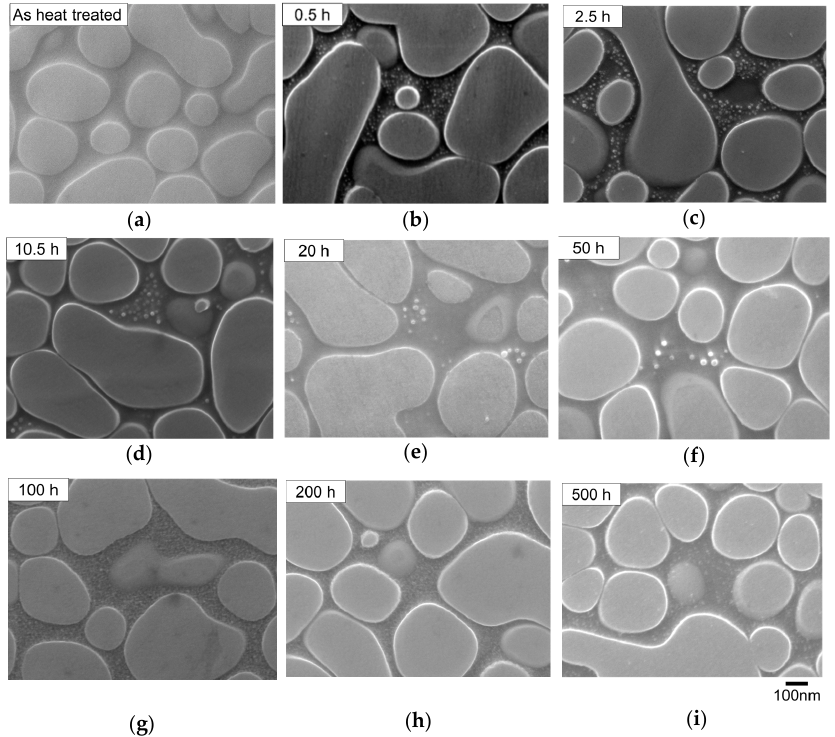
Figure 3. Microstructure after long-term aging at 760 °C without load at higher magnitude of Figure 2. ( a ) As heat treated, ( b ) 0.5, ( c ) 2.5, ( d ) 10.5, ( e ) 20, ( f ) 50 h, ( g ) 100, ( h ) 200, ( i ) 500 h aged at 760 °C.